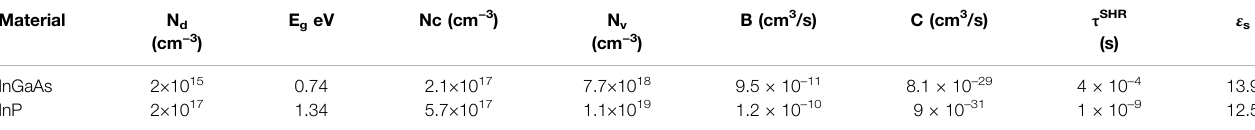
TABLE 2 | Parameters used in calculation [13].